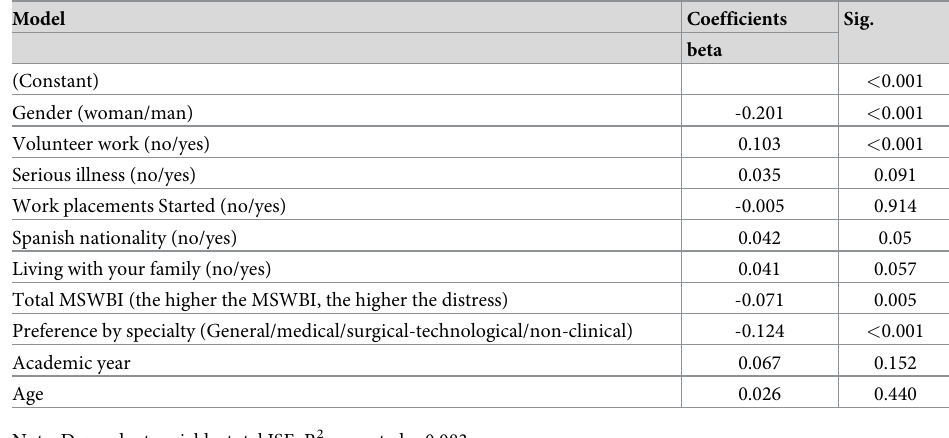
Table 5. Linear regression model of Jefferson Scale of Empathy (JSE) scores and other variables. Model